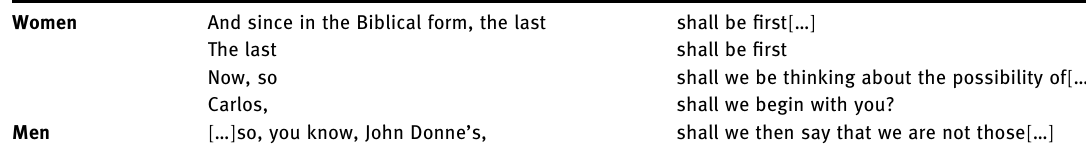
Table 31: Concordance “ Shall ”